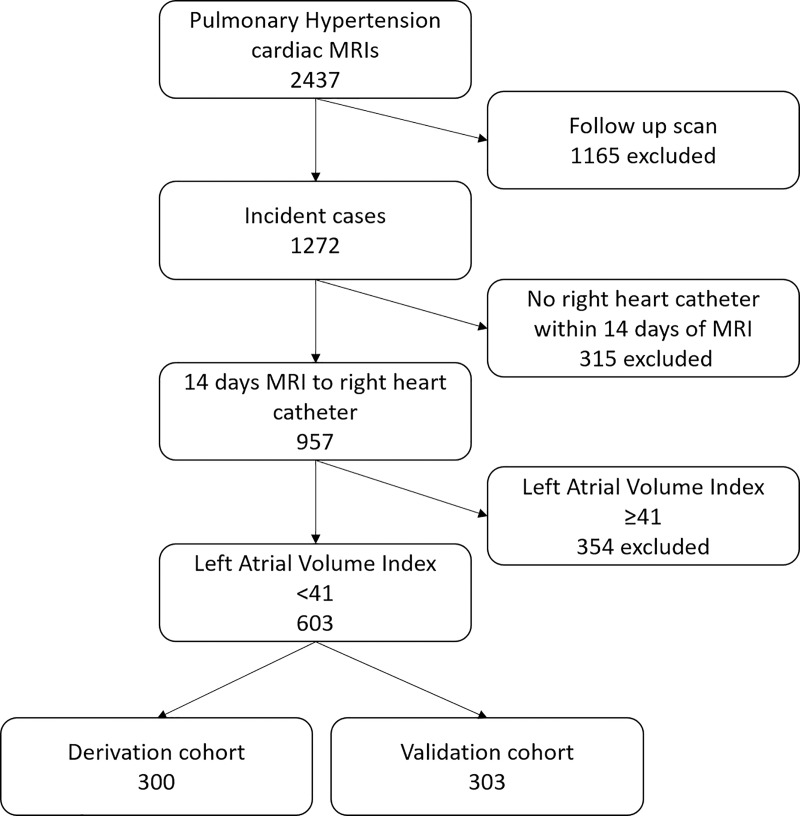
Patient flowchart.